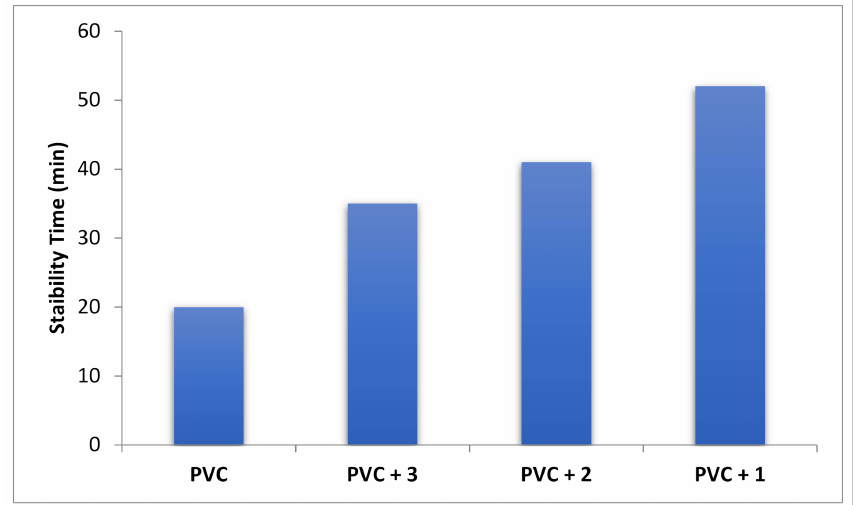
Figure 5. The stability time of PVC